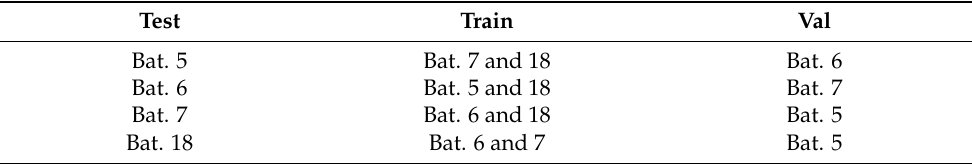
Table 2. Overview of the test, training and validation set combination. Test